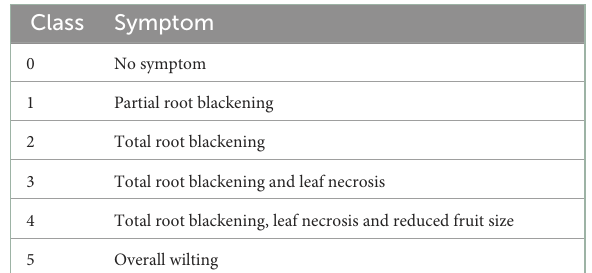
TABLE 1 Symptom severity classes on the pathogen-inoculated strawberry